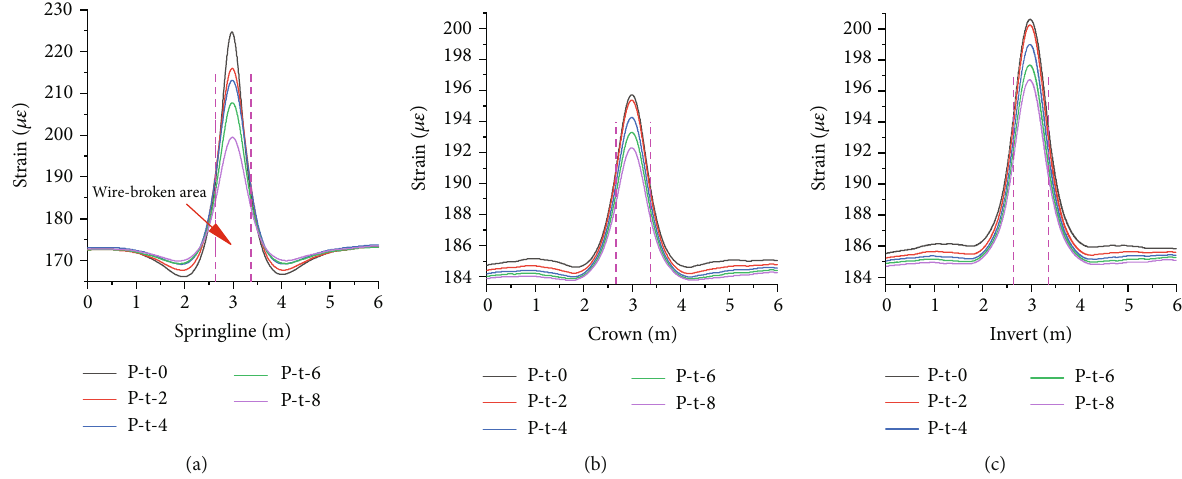
Figure 6: Circumferential strain of the inner concrete core under combined loads: (a) springline; (b) crown; (c) invert.